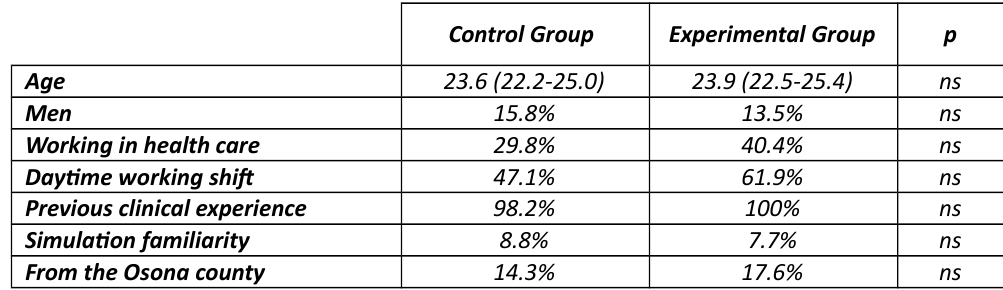
Table 1. Results of comparing the Control and the Experimental Groups